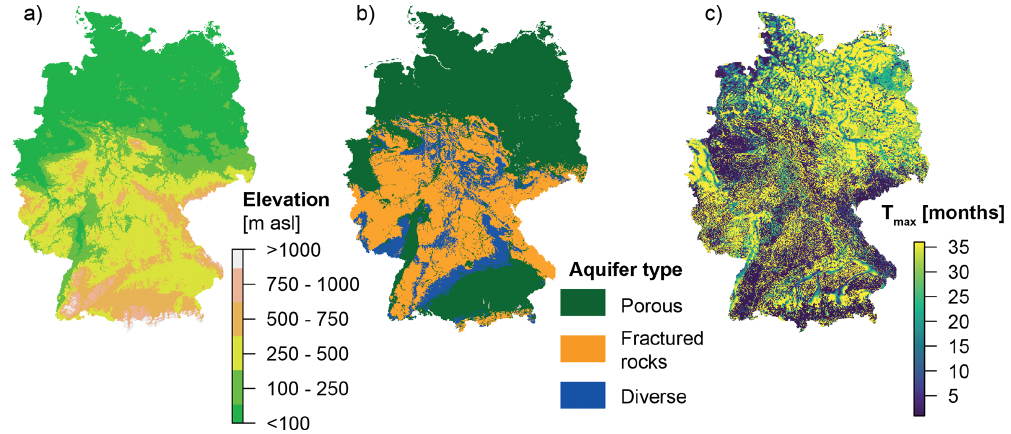
Figure 1. Study area. (a) Topographic map, (b) main aquifer types (taken from BGR and SGD, 2016) and (c) precipitation accumulation times that have the maximum correlation with groundwater T max (taken from Hellwig et al.,